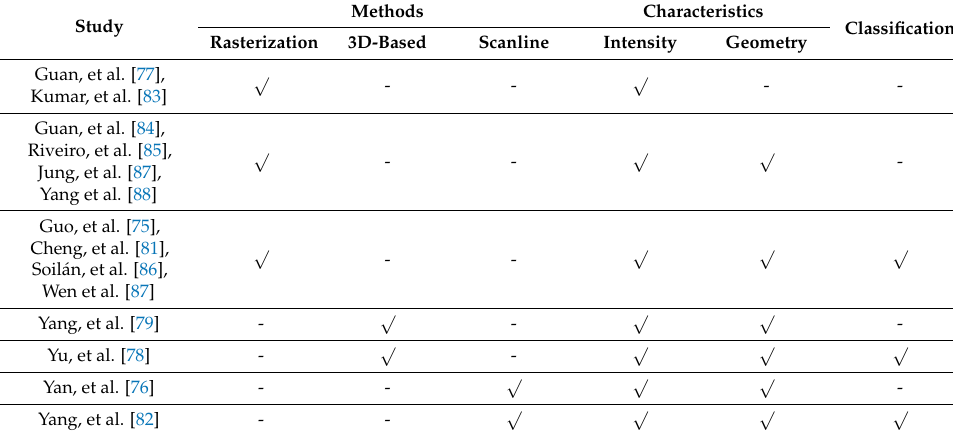
Table 5. Summary of road marking extraction